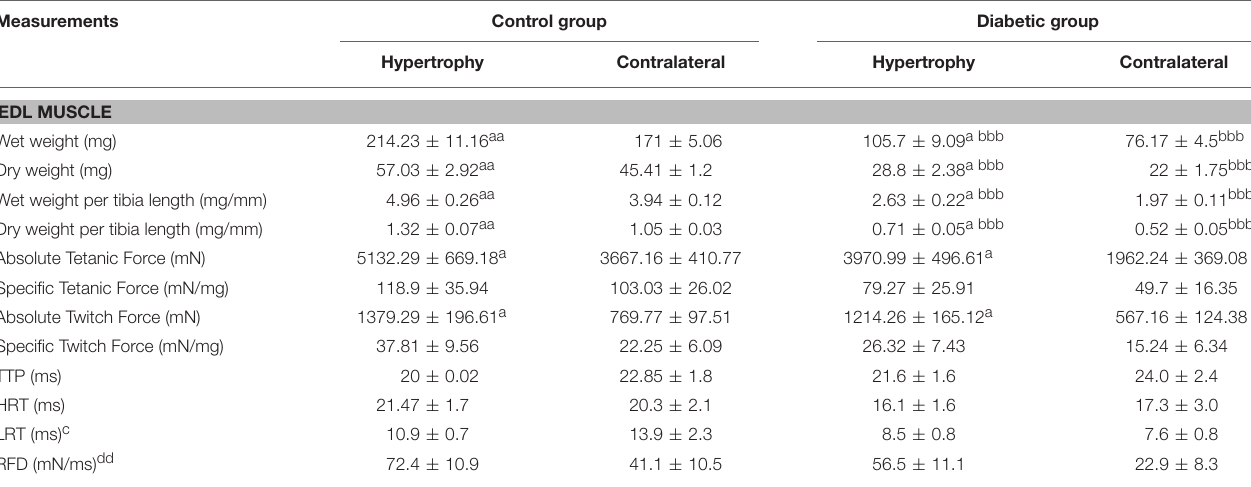
TABLE 2 | EDL mass, strength, and contractile properties after 30 days of